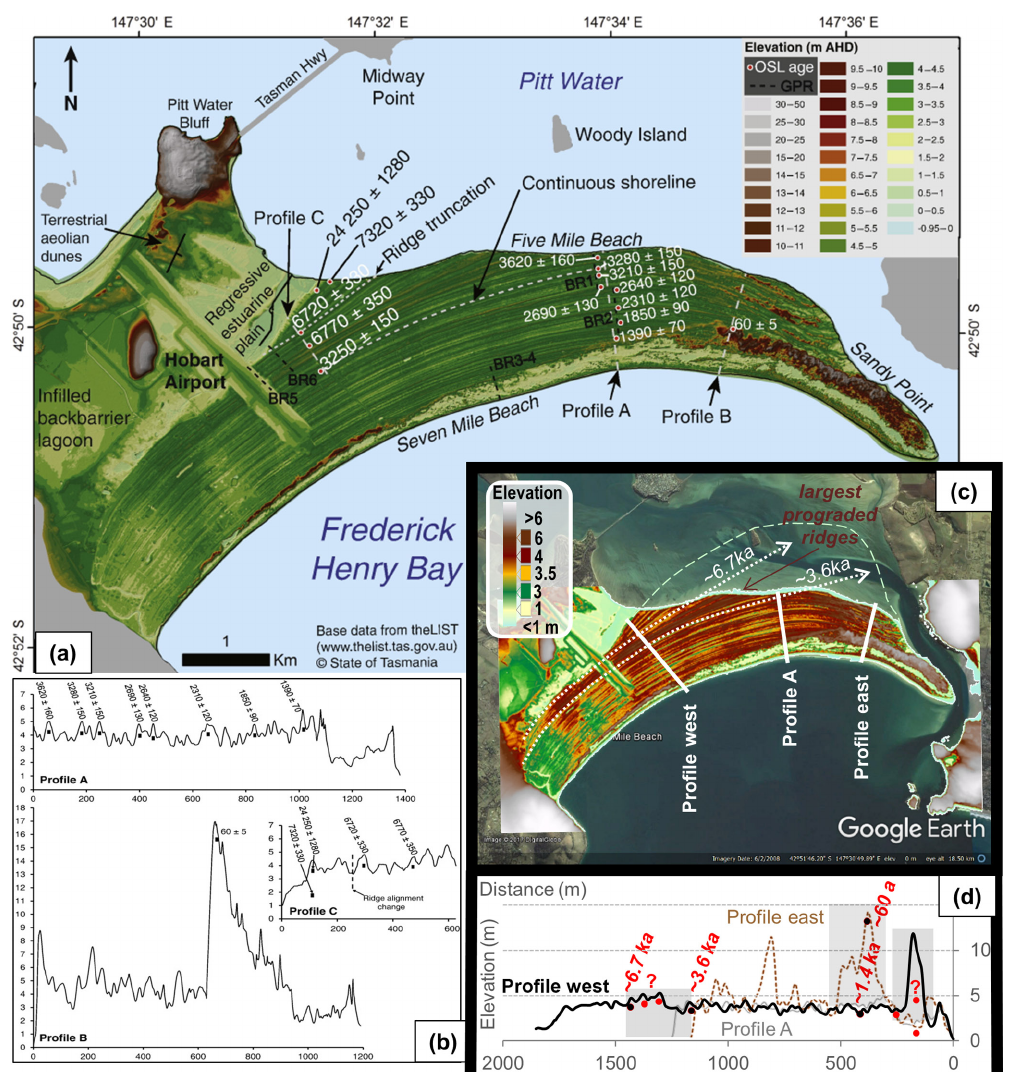
Figure 8. Morphology and chronology of Seven Mile Barrier, Tasmania, Australia. (a) Lidar data showing the location of topographic profiles in (b) and GPR transects (BR no.) as well as OSL ages in years from Oliver et al. (2017a). (c) Google Earth image augmented with 5m lidar (Geoscience Australia; http://www.ga.gov.au/elvis/, last access: June 2017). This combined image shows the potential size of the barrier prior to erosion (dashed green line) and the possible lateral extent of the largest set of prograded foredune ridges which formed between ∼ 6 . 7 and 3.6kyr ago (darkest brown ridges within the white dashed lines). (d) Topographic profile across the east and west portion of the barrier (location in c ) overlain on profile A from Oliver et al. (2017a). Profile west transects the entire Holocene barrier, displaying the largest prograded ridges between ∼ 6 . 7 and 3.6kyr ago and the extraordinary height of the foredune that formed in the last 500 years, which is missing in (b) . Overlaying profile east shows the large 60-year-old dune unconformably deposited above the ∼ 1400-year-old low-lying foredune, indicating relatively recent barrier transgression. Note that gaps in the data coincide with interpreted pauses in progradation by Oliver et al. (2017a), with grey boxes indicating an absence of GPR data and red dots indicating a lack of OSL ages. Also note the vertical age discrepancy in profile C in (b) and how GPR could help to understand these age models. Figure modified from Oliver et al. (2017a) and Dougherty